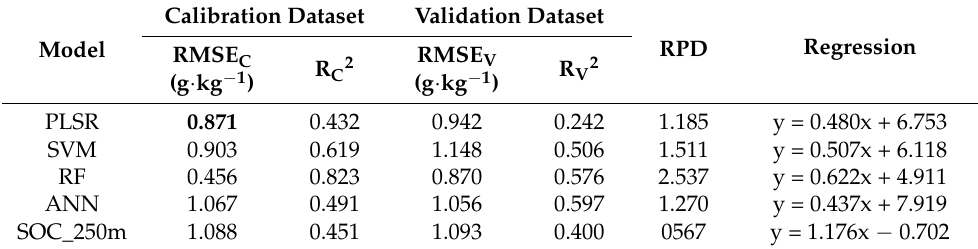
Figure 3. Predicted and observed SOC for the calibration dataset. Table 4. Model prediction performance Table 4. Model prediction performance statistics.